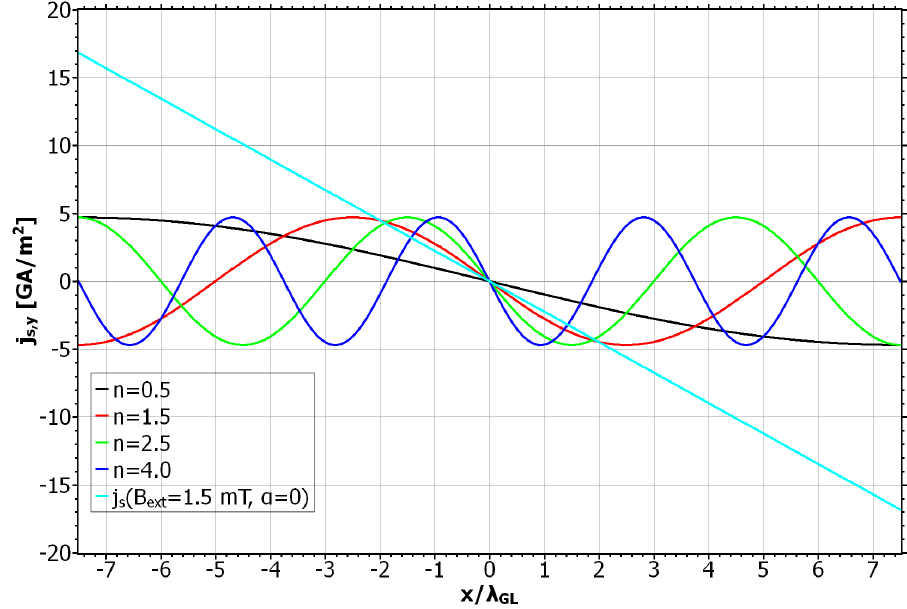
Figure 7. Supercurrent distribution of a reference state with α = α s and without vortex. y-component of the supercurrent along the x-axis for values of n for which the depinning current becomes extremal. Pinning is observed to happen when the spin–orbit field becomes maximal around the left edge x = − 7.5 λ GL , whereas the flux motion is enhanced for negative